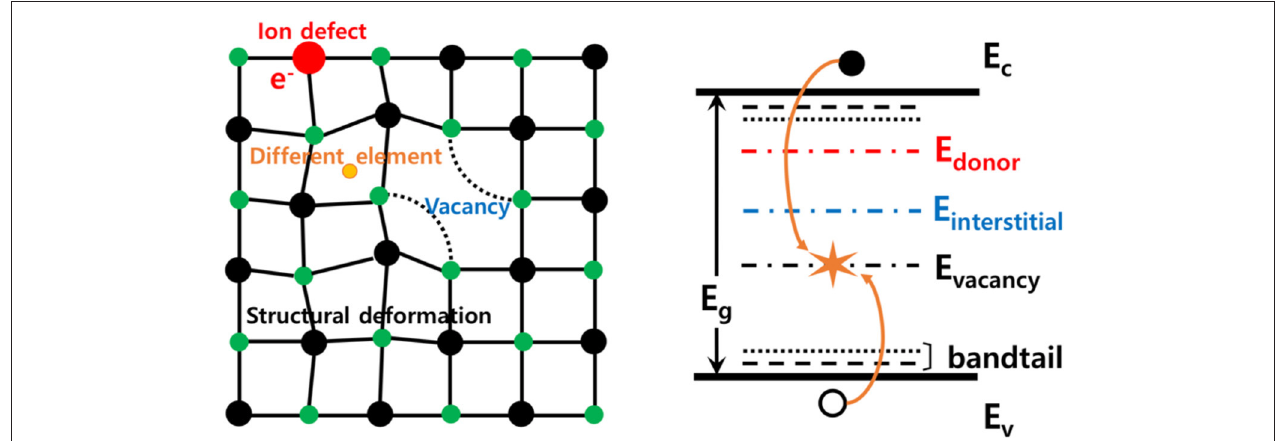
FIGURE 4 | Simple viewpoint of relationship between defects and energy